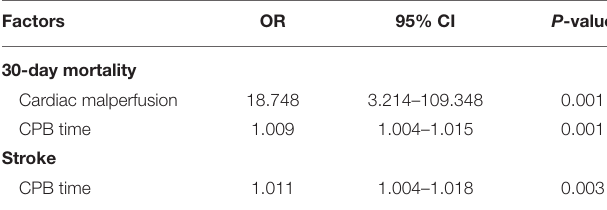
TABLE 4 | Multivariable logistic regression analysis results for 30-day mortality and stroke.